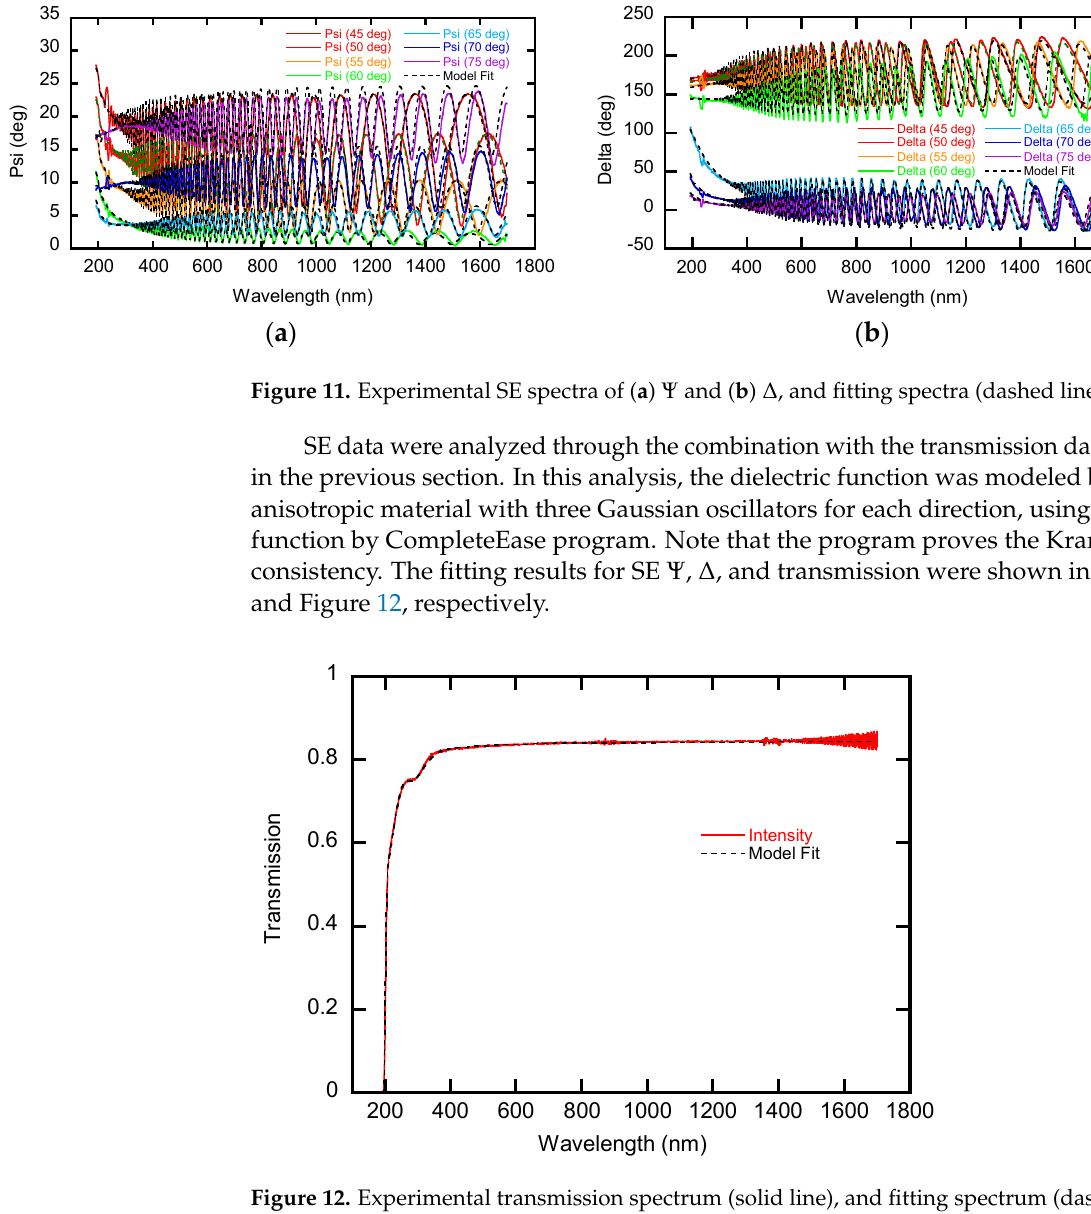
Figure 12. Experimental transmission spectrum (solid line), and fitting spectrum (dashed line).